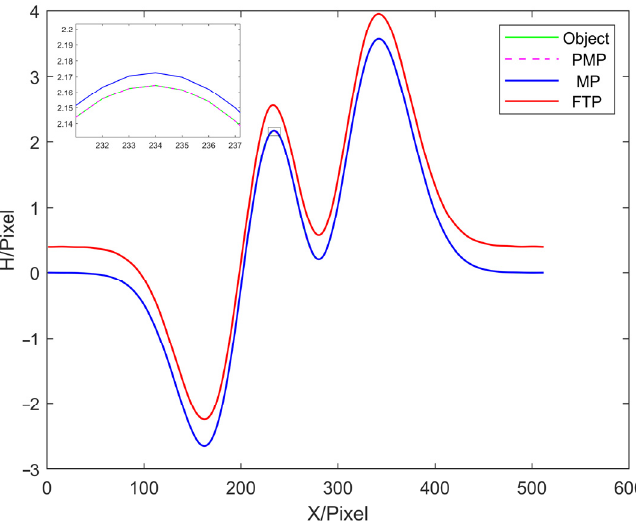
Figure 4. Error distributions. ( a ) MP; ( b ) PMP; ( c ) FTP.